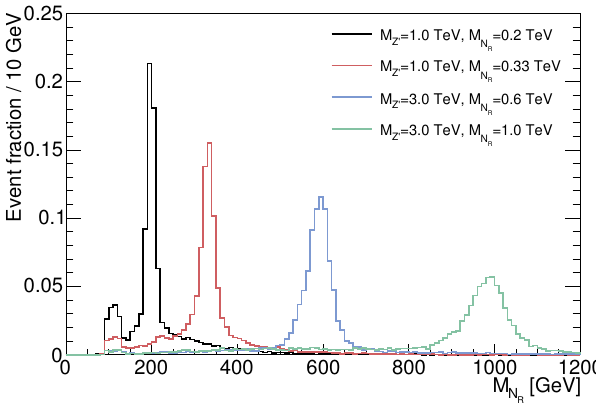
Figure 3 . Reconstructed N R mass for several benchmark